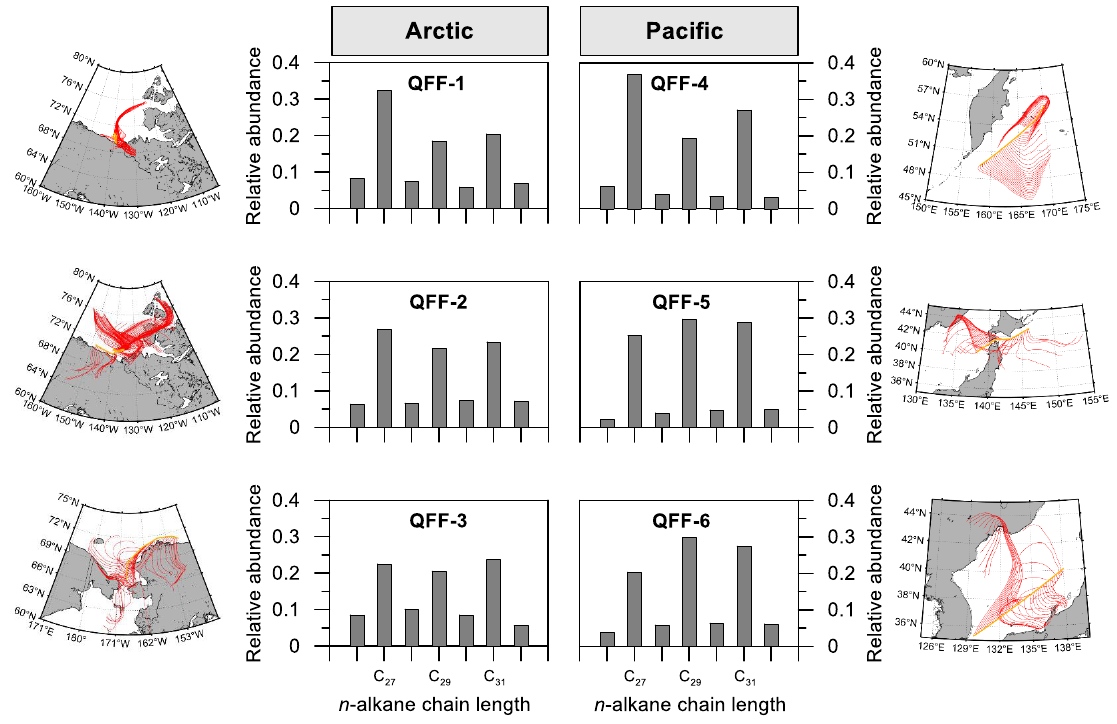
Figure 2. Backward air-mass trajectories at 50 m above ground level for each sample and fractional abundances of high molecular weight (HMW) n -alkanes for the range of C 26 –C 32 . The yellow lines indicate the ship track lines.